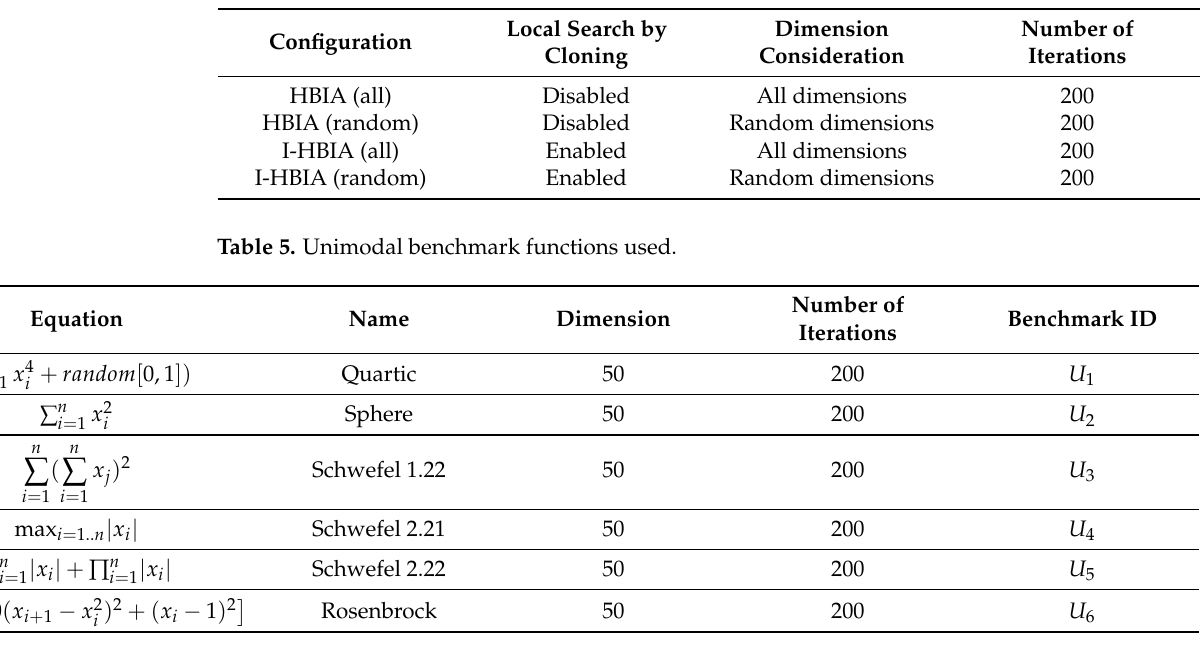
Table 4. Used configurations.